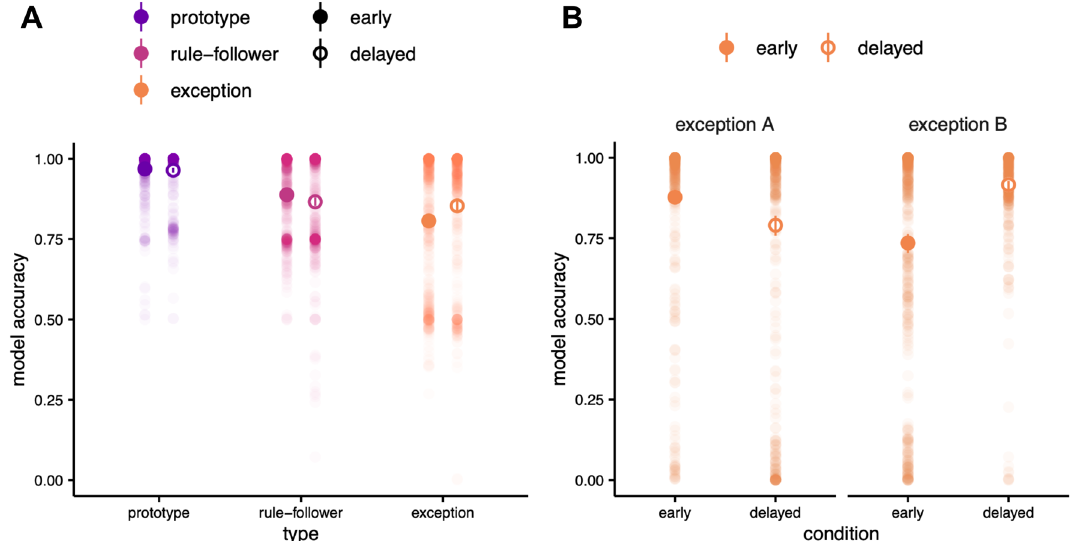
Figure 4. ( A ) Model categorization accuracy for all stimuli. Large points indicate the median of bootstrapped mean accuracies for stimulus types in the early (filled) and delayed (open) sequences. Error bars represent bootstrapped 95% confidence intervals. Small dots show average accuracy for each batch. The model results for exception items were consistent with behavioural findings: accuracy was significantly higher for exceptions in the delayed condition. ( B ) Exception results, separated by category. Again, the model findings were consistent with behavioural results: the advantage for exceptions in the delayed condition was driven by the category B